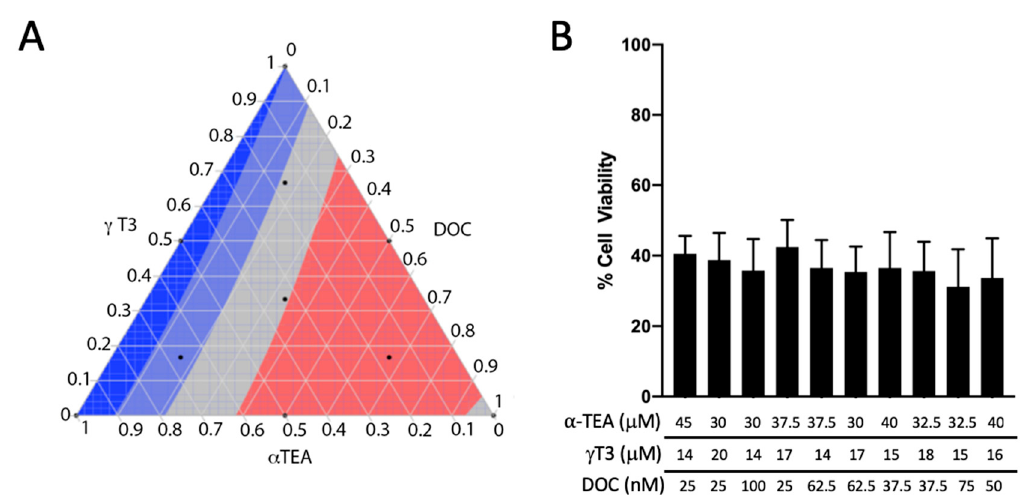
Figure 3. Analysis of γ -T3, α -TEA, and DOC treatment combinations in DU-145 cells. ( A ) Ternary plot displaying MDRSM analysis conducted using the same treatment combinations as used for PC-3 cells in Figure 2C,D. The most effective combination for reducing cell viability was calculated to be 30 µM α -TEA, 16.4 µM γ -T3, and 70 nm DOC. ( B ) Bar graph displaying cell viability data used to generate ternary plot B. No significant differences in treatment response were detected among the various combinations.